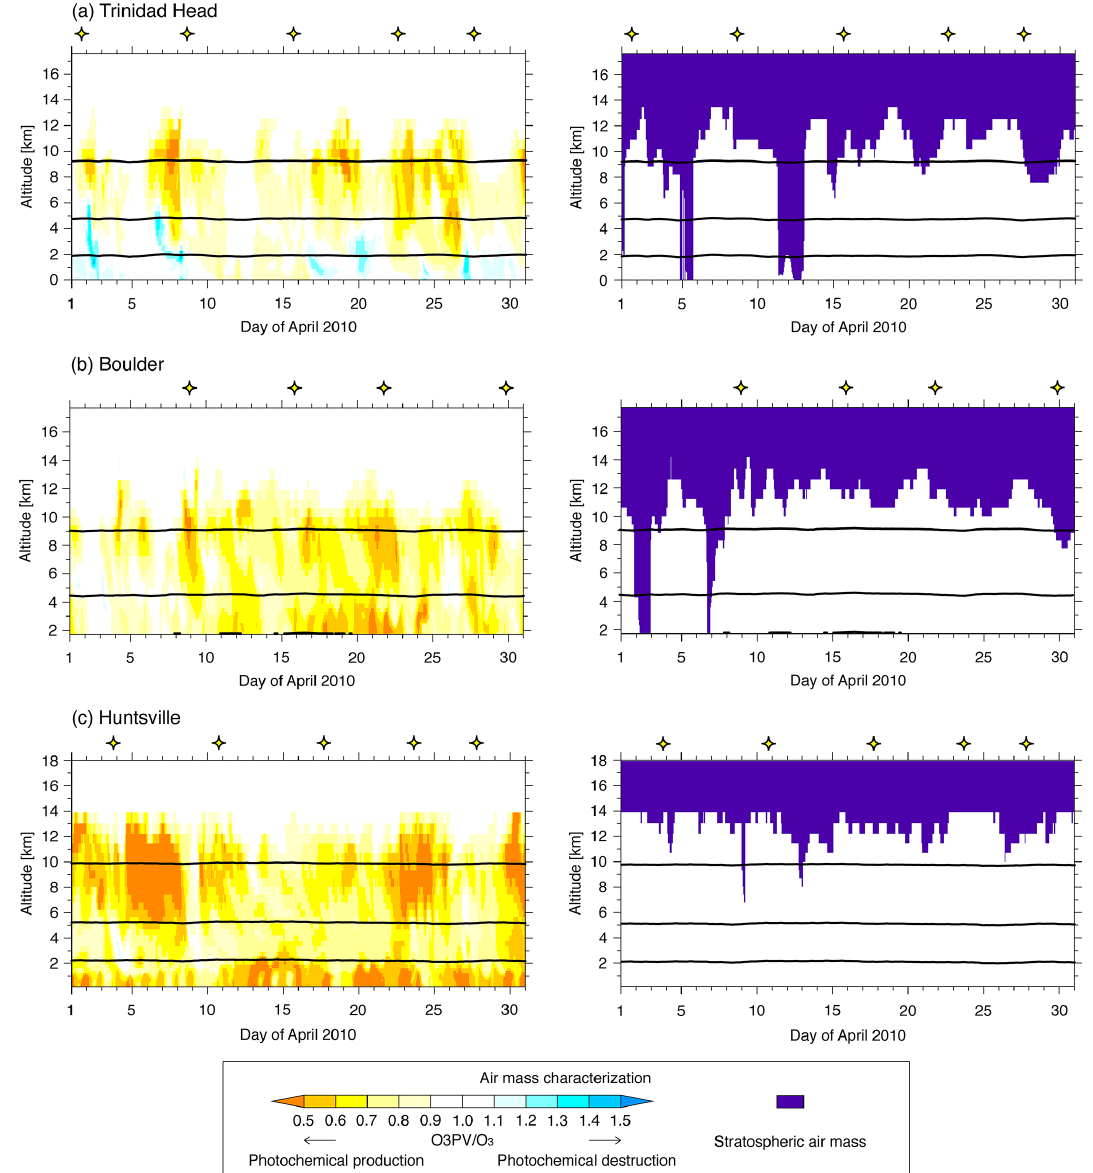
Figure 9. Curtain plot of model-diagnosed air mass characterization for (left) O3PV / O 3 and (right) stratospheric air mass at US ozonesonde sites of (a) Trinidad Head (CA), (b) Boulder (CO), and (c) Huntsville (AL) during April